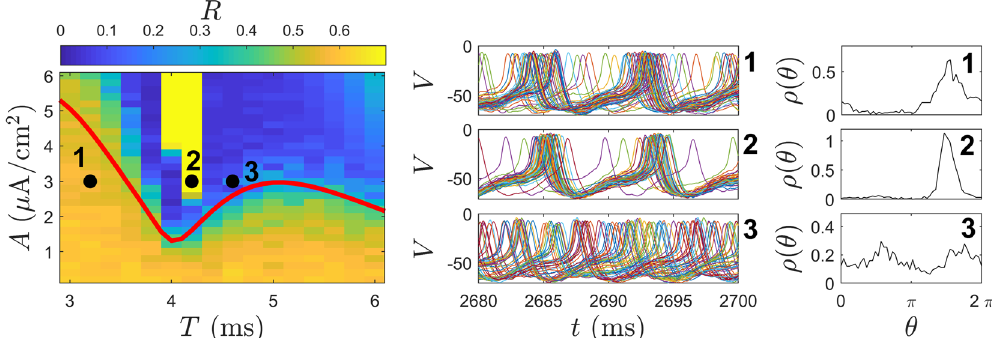
Figure 3. In the left panel, the average value of the Kuramoto order parameter (12) is shown for various combinations of stimulation frequency and amplitude after the transient behavior has died out. The red line gives a prediction for when desynchronization will occur based on the analysis of the underlying Fokker-Planck equation. Details of simulations using three different parameter sets represented with black dots are also shown. The middle panels show voltage traces for 50 representative neurons (in units of mV) over the course of about 2 periods. The right panels give a snapshots of the probability density inferred from the phase